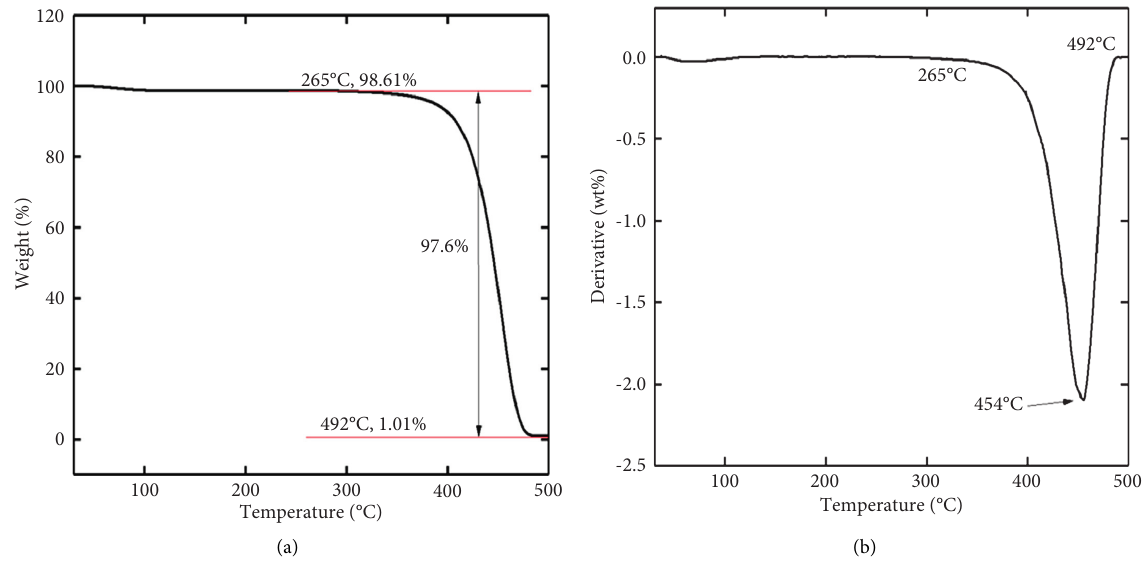
Figure 3: TG testing results of the PA6